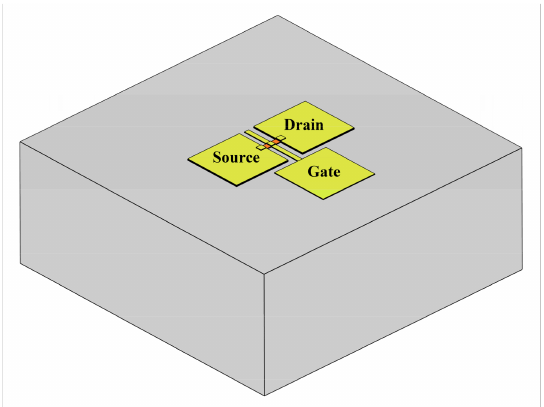
Figure 2. 3-D thermal model of the simulated β -Ga 2 O 3 MOSFET. (not drawn to scale).